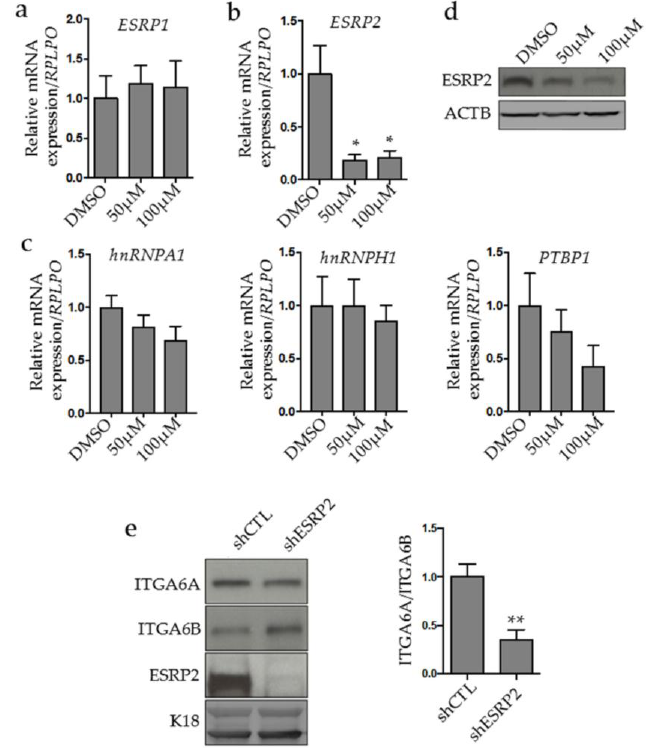
Figure 3. MYC regulates ITGA6 splicing through epithelial splicing regulatory protein 2 (ESRP2). Quantitative RT-PCR analysis of ESRP1 ( a ), ESRP2 ( b ) and heterogeneous nuclear RNA-binding protein H1 (hnRNPH1), hnRNPA1 and polypyrimidine tract-binding protein 1 (PTBP1) ( c ) mRNA expression in CRC T84 cells treated with the MYC inhibitor at 50 and 100 µM for 48 h. *: statistically significantly different ( p ≤ 0.05) from DMSO control. Data are expressed normalized to RPLPO expression as a validated housekeeping gene. ( d ) Representative immunoblot analyses of ESPR2 protein level expression. β-actin (ACTB) was used as loading control. ESRP2 knockdown alters ITGA6 splice variant expression. ( e ) Representative immunoblot and densitometric analyses of ITGA6A, ITGA6B and ESRP2 in CRC cells knocked down for ESRP2. Cytokeratin 18 (K18) was used as loading control. **: statistically significantly different ( p ≤ 0.01) from control sh (shCTL). 2.4. MYC Binds to ESRP2 and ITGA6 Promoters